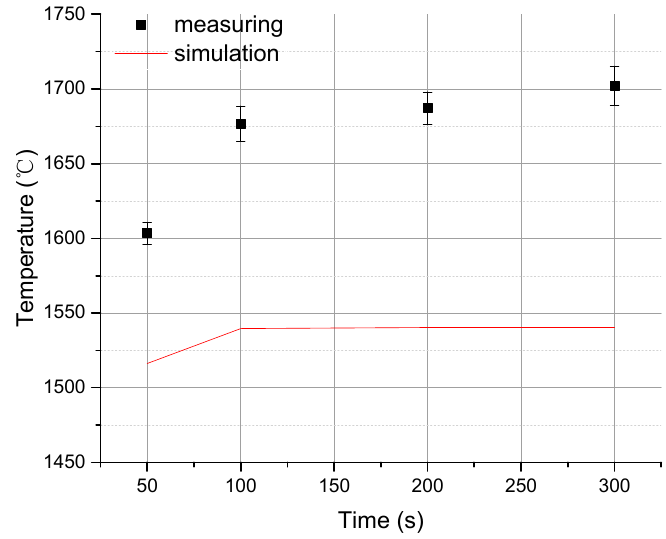
Figure 6. Measured value vs. simulated value in surface temperature in the focal spot region of the diamond composite anode.